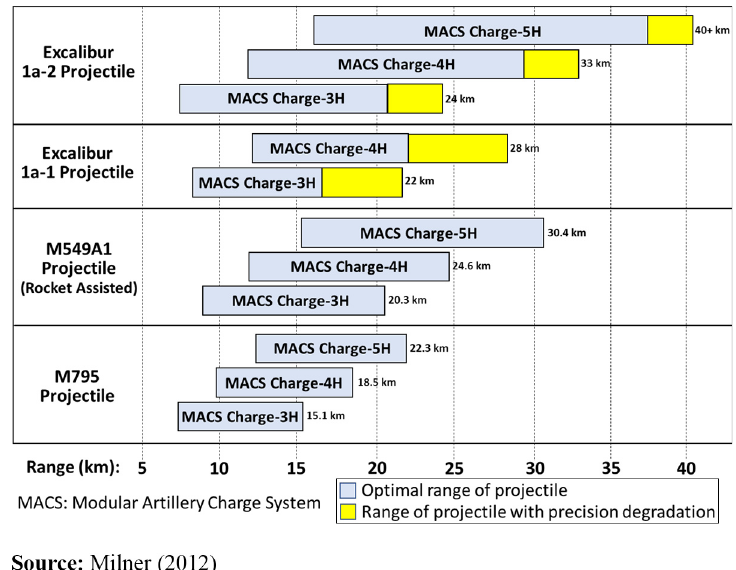
Figure 1. M982 tested ranges for 155mm projectiles in comparison to the M549A1 and